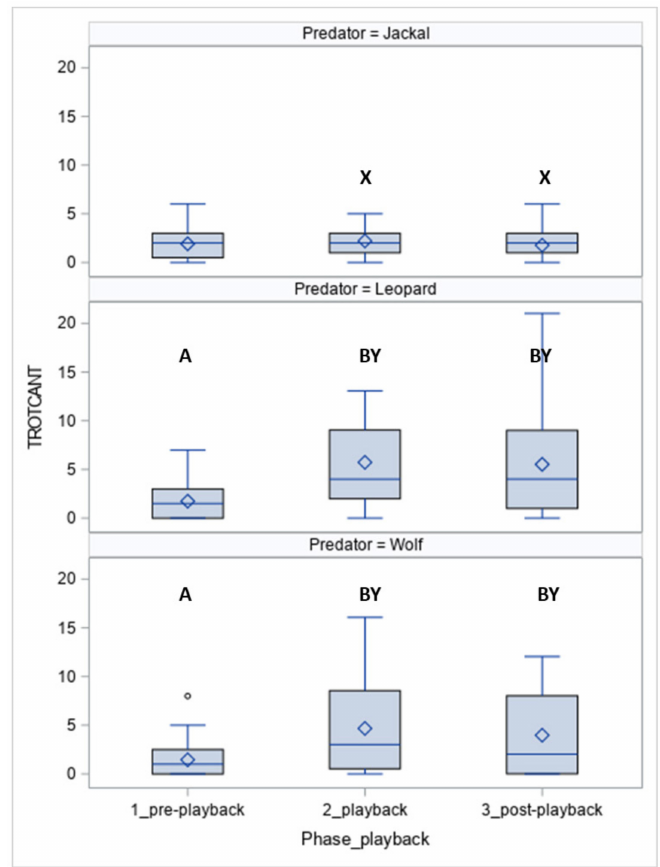
Figure 6. The number of steps in trot and canter (TROTCANT) in horses exposed to the vocalisation of predators. Values with A, B letters di ff er significantly at p < 0.01 between phases 1–3 (pre-, playback and post-playback); values with X, Y, Z letters di ff ers significantly at p < 0.01 between predators. Values with no letter do not di ff er to other